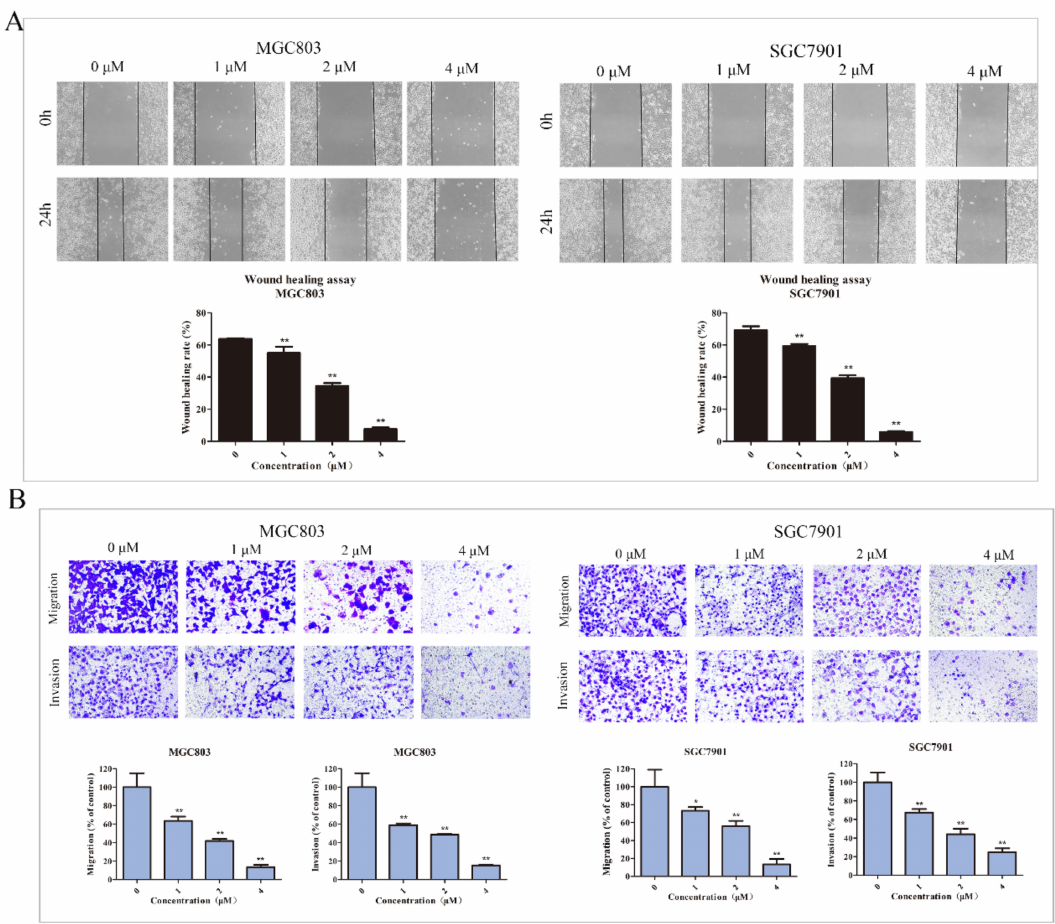
Figure 5. DHCE inhibited migration and invasion of gastric cancer cells. ( A ) The wound heal- ing assay of MGC803 and SGC7901 cells. After making a linear wound, cells were treated with DHCE (0, 1, 2, or 4 µ M) diluted with serum-free RPMI-1640 for 24 h. The photographs were captured at 0 and 24 h under an inverted microscope with a magnification of 100 × . The wound area was measured, and the migration potential of each group was quantified. ( B ) Trans-well migration and invasion assay of MGC803 and SGC7901 cells. Images were photographed using an inverted microscope under a magnification of 200 × . The number of invading cells were counted, and the migration and invasion potentials of each group were quantified. The experiment was carried out in triplicate, and the statistical results are expressed as the means ± SD (* p < 0.05 and ** p < 0.01 compared with the control